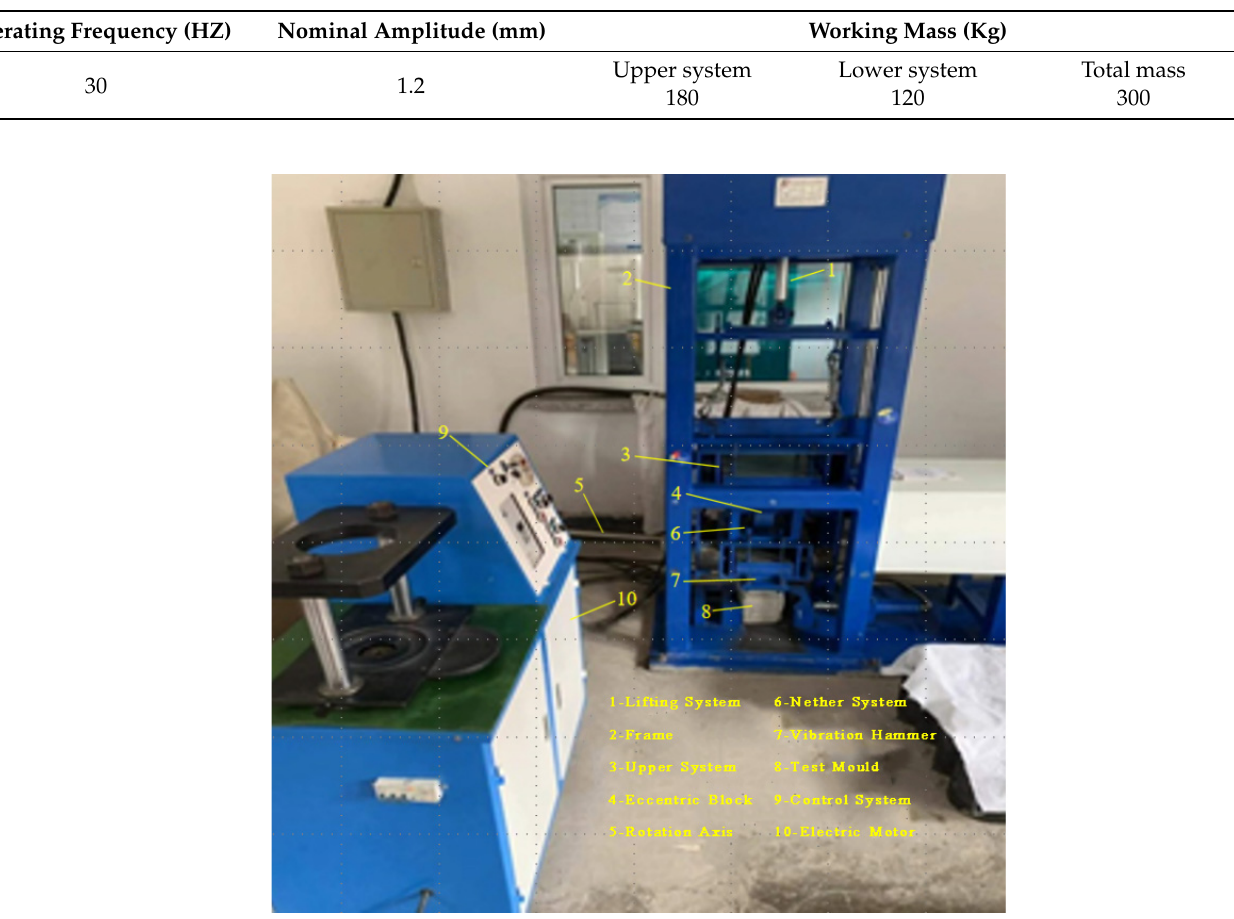
Figure 1. Schematic diagram of the structure of the vibration meter used in this study. Table 4. Parameter Settings of Vibration